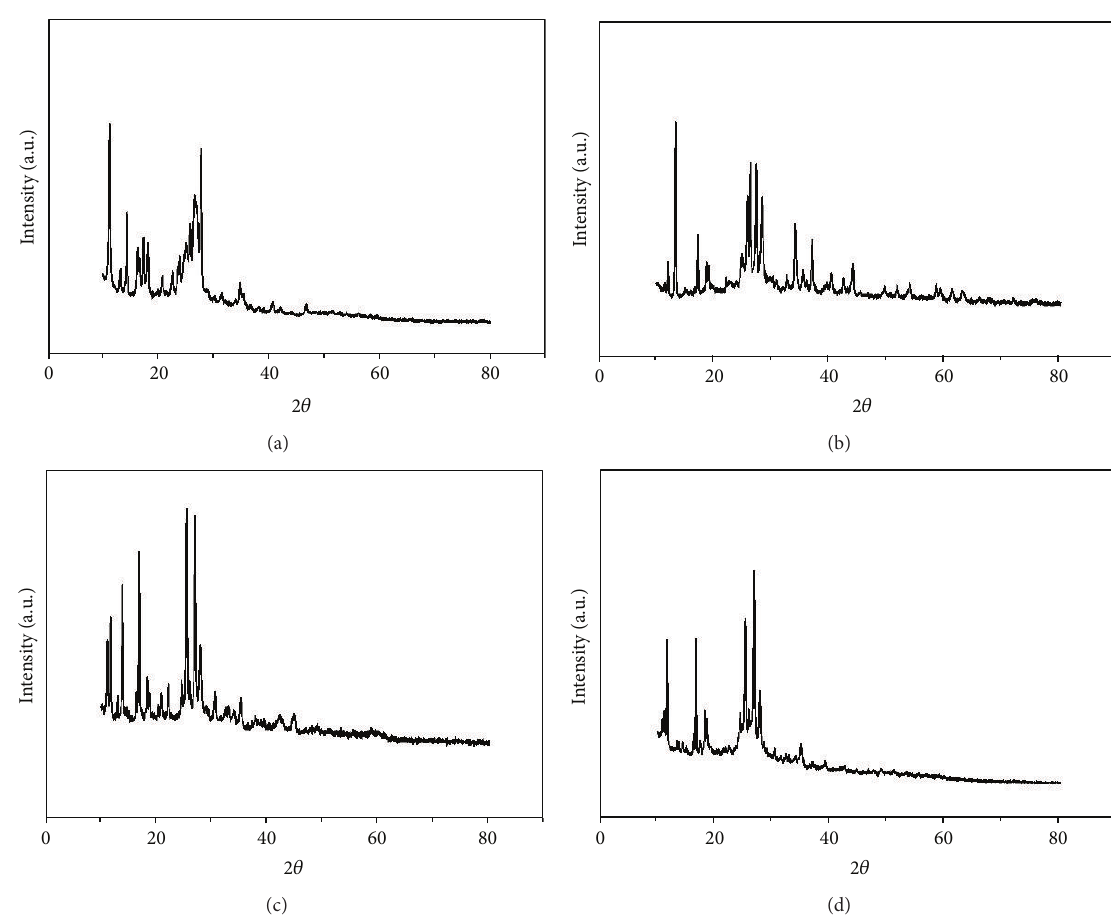
Figure 8: XRD patterns of (a) BEF ligand, (b) BEF–Cu, (c) BEF–Ni, and (d)